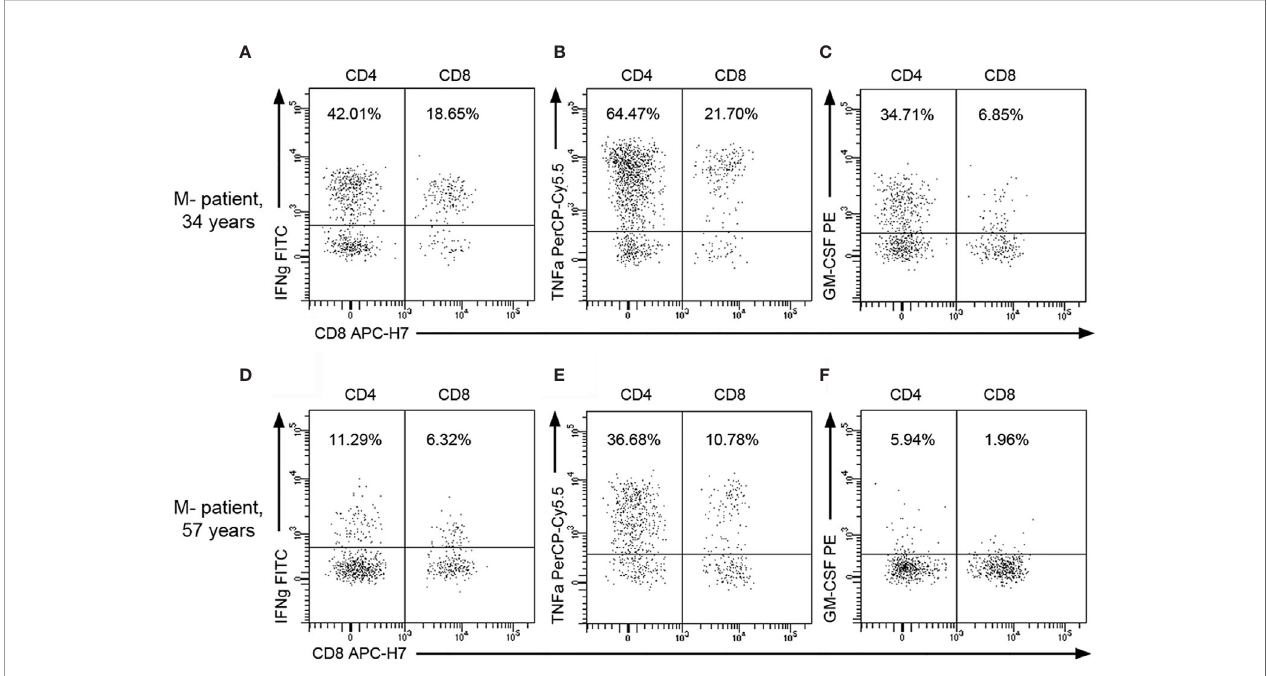
FIGURE 4 | Representative fl ow cytometry images of CSF T lymphocytes producing cytokines in M- patients. Representative dot plots showing intracellular cytokine production by CSF CD4+ and CD8+ T lymphocytes from a young M- patient [34 years old; (A – C) ] and from an old one [57 years; (D – F) ]. Percentages over total CSF CD45+ lymphocytes are indicated on plots. GM-CSF, Granulocyte-Macrophage Colony Stimulating Factor; IFNg, Interferon-gamma; TNFa, Tumor necrosis